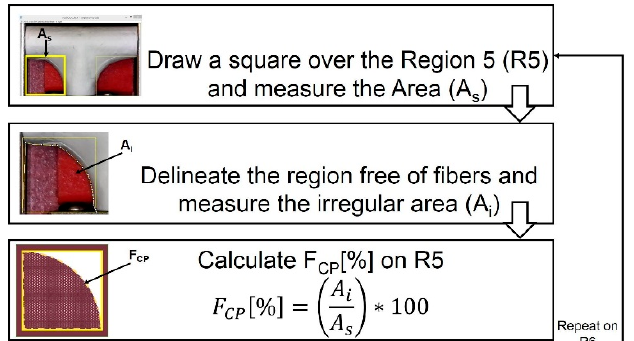
Figure 8. The position to observe the sample and analyze F CP (%) related to the direction it was electrospun to characterize how the electrospun material was deposited over the mandrel.